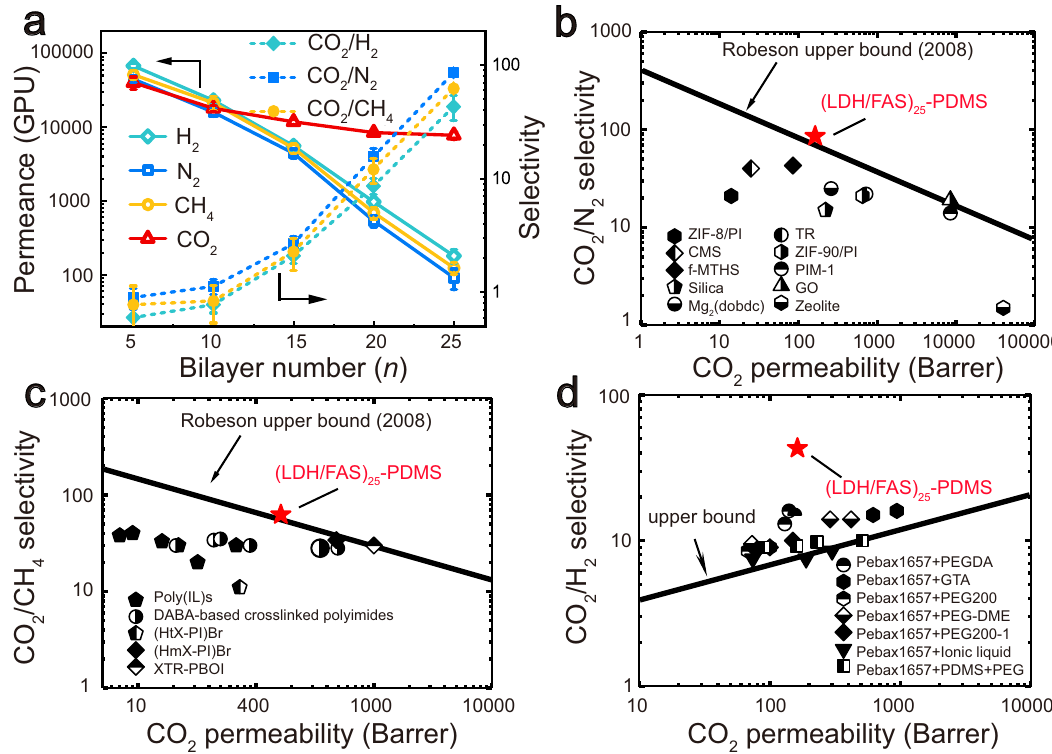
Fig. 4 Permeability and selectivity for pure gases. a The H 2 , CO 2 , N 2 , CH 4 permeance and CO 2 /H 2 , CO 2 /N 2 , CO 2 /CH 4 selectivity for (LDH/FAS) n -PDMS membrane, 27 kPa; 298 K. b CO 2 /N 2 , c CO 2 /CH 4 and d CO 2 /H 2 separation performance of (LDH/FAS) 25 -PDMS membrane and representative membranes reported in the